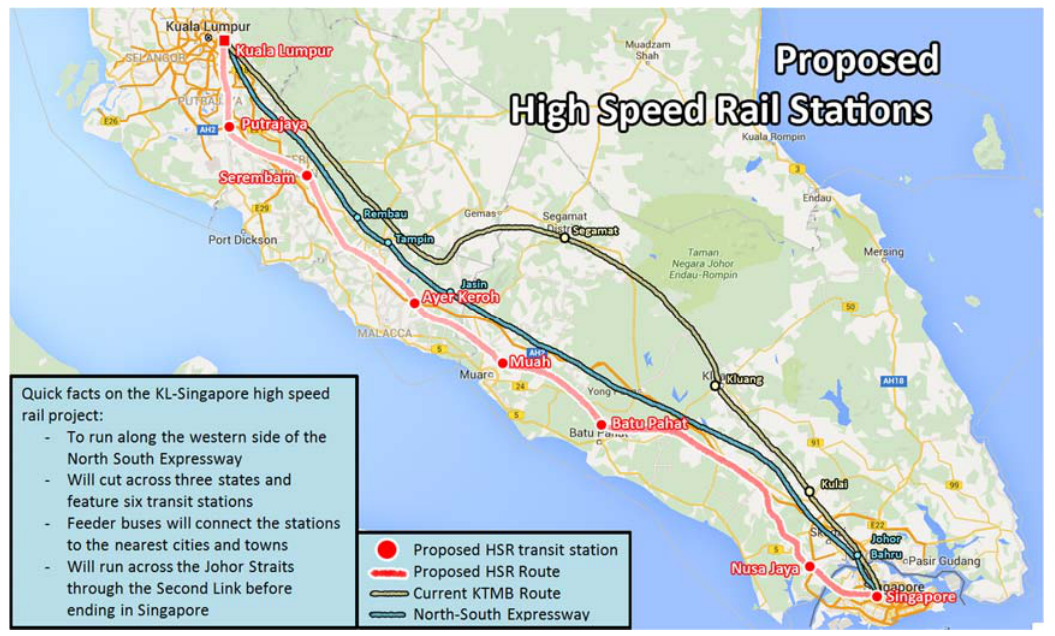
Figure 1. Proposed High Speed Rail Malaysia to Singapore (courtesy: SPAD).